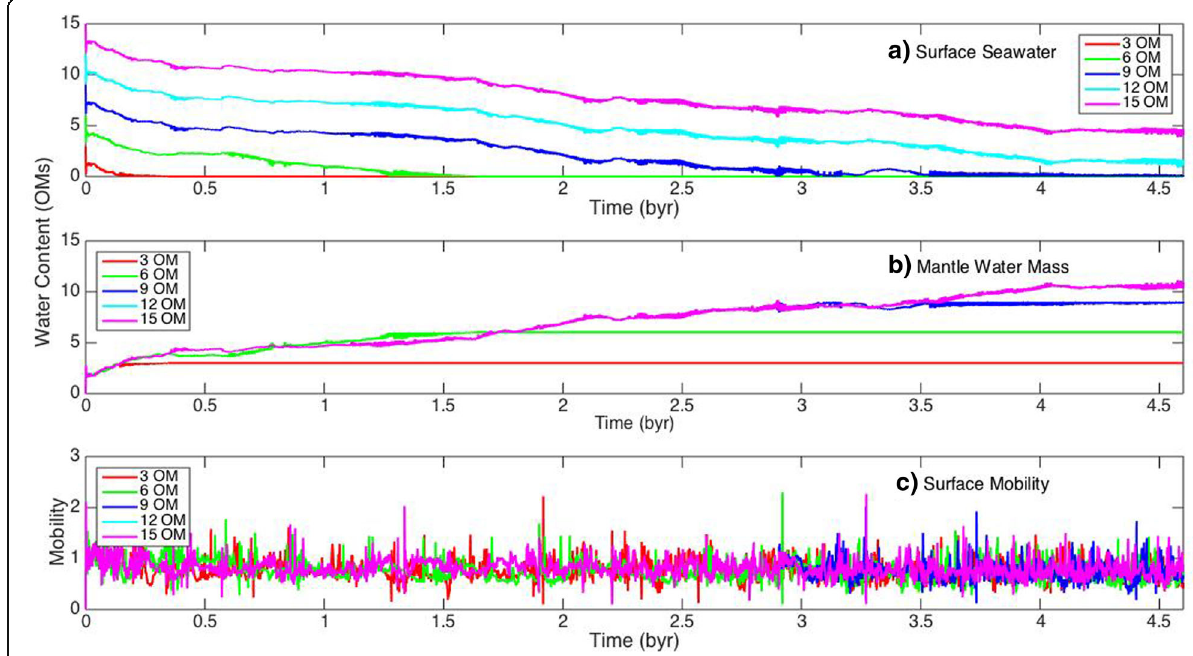
Fig. 6 Temporal variations in the mass of a surface seawater, b mantle temperature, and c surface mobility varying with the total amount of water in the entire planetary system. For cases with 12 and 15 ocean masses, the mantle behaviors (water content and surface mobility) are the same due to the remaining surface